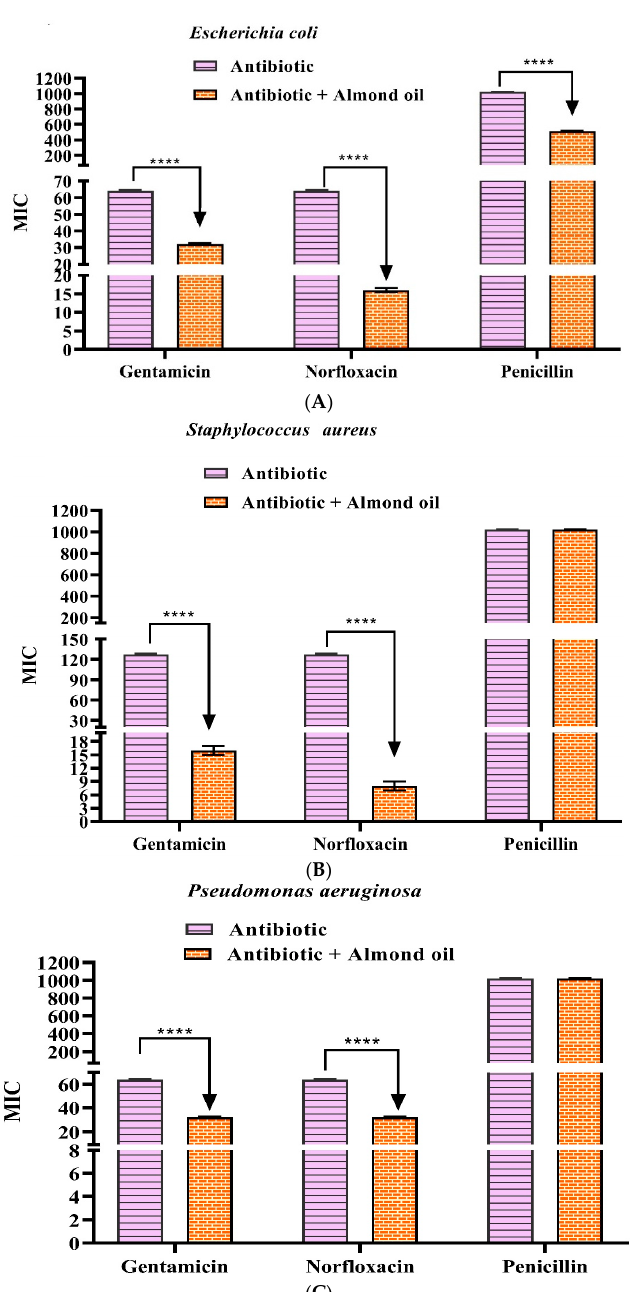
Figure 3: Potentiation of antibiotic action by the fixed oil of the A. almond against the analyzed strains: Escherichia coli EC–06 ( A ), Staphyloccus aureus SA–10 ( B ), and Pseudomonas aeruginosa PA–24 ( C ). Values are expressed as geometric mean ± mean standard error (SEM). Two-way ANOVA followed by the Bonferroni test was used. **** p < 0.0001, antibiotic alone vs. combined